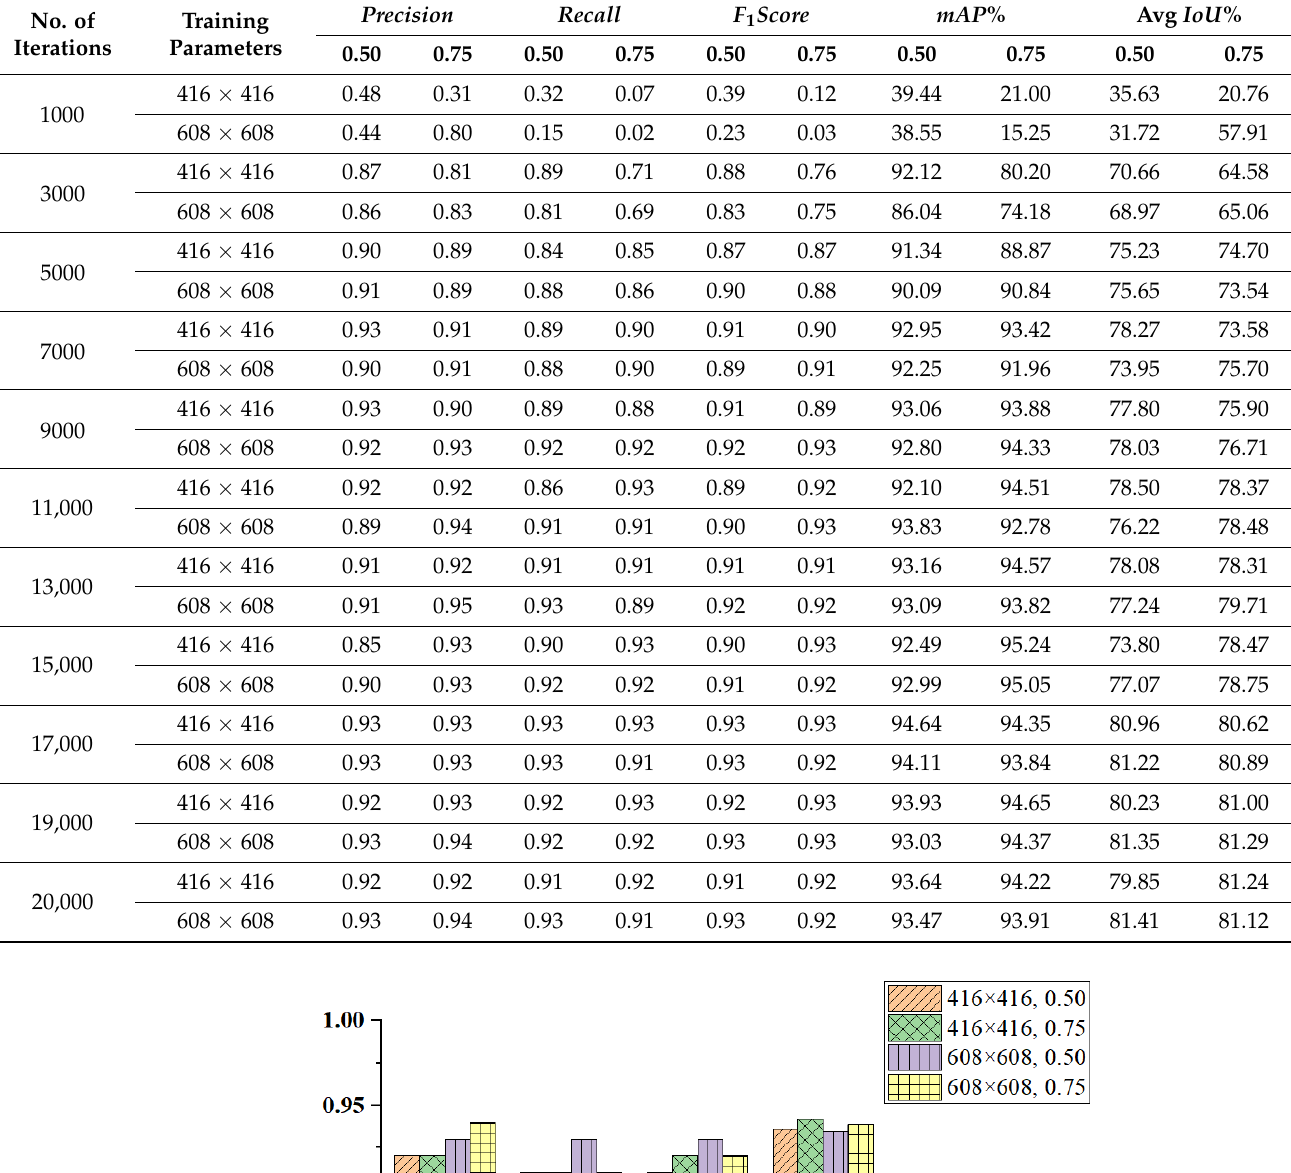
Table 4. Performance parameters at different iterations of training.